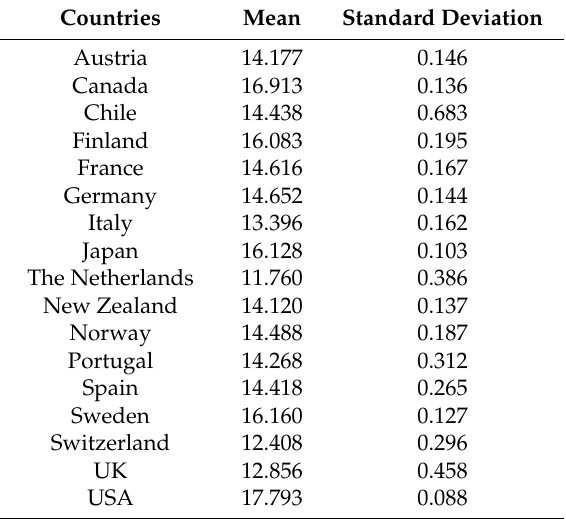
Table 4. Mean and volatility of wood pulp production,